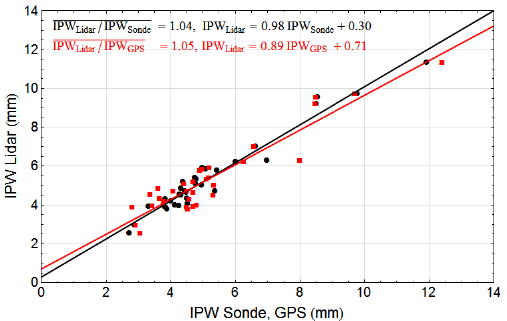
Fig.13. ComparisonofintegratedprecipitablewaterfromtheALVICElidarusingthebestestimateproductand Fig. A8. Comparison of integrated precipitable water from the correctedRS92(black)andSuomiNetGPS(red). Thelidarresultsare4–5%moisterthanboththeradiosonde ALVICE lidar using the best estimate product and corrected RS92 andGPS. (black) andSuomiNet GPS (red). The lidar results are 4–5% moister than both the radiosonde and 49